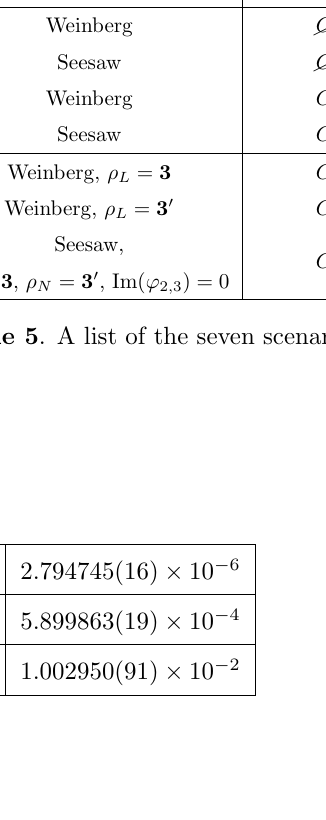
Table 6 . Left panel: charged lepton Yukawa couplings renormalized at the m Z scale, from ref. [59]. Right panel: neutrino oscillation data, from ref. [60]. The squared mass di(cid:11)erence (cid:1) m 2 to (cid:1) m 2 for normal ordering and (cid:1) m 2 for inverted ordering. Errors, shown in brackets, are the 31 32 average of positive and negative 1 (cid:27) deviations. The (cid:31) 2 function is not gaussian along the sin 2 (cid:18) 23 direction and our de(cid:12)nition overestimates the